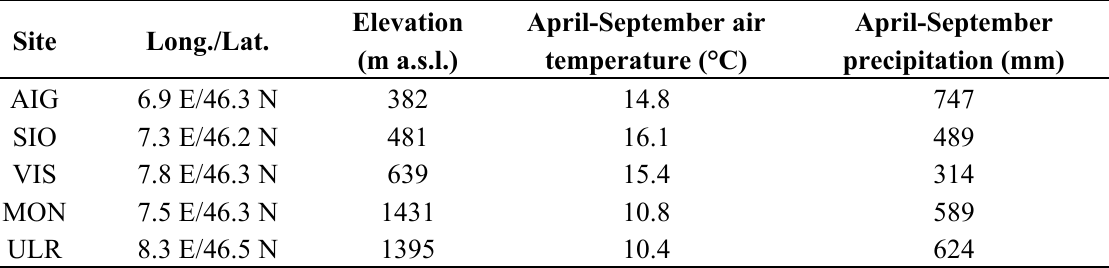
Table 1. Location, elevation and climate of the five sites selected for the estimation of the daily irrigation requirements over 1981-2009. The sites are: Aigle (AIG), Sion (SIO), Visp (VIS), Montana (MON) and Ulrichen (ULR) (see also Figure 1). Site